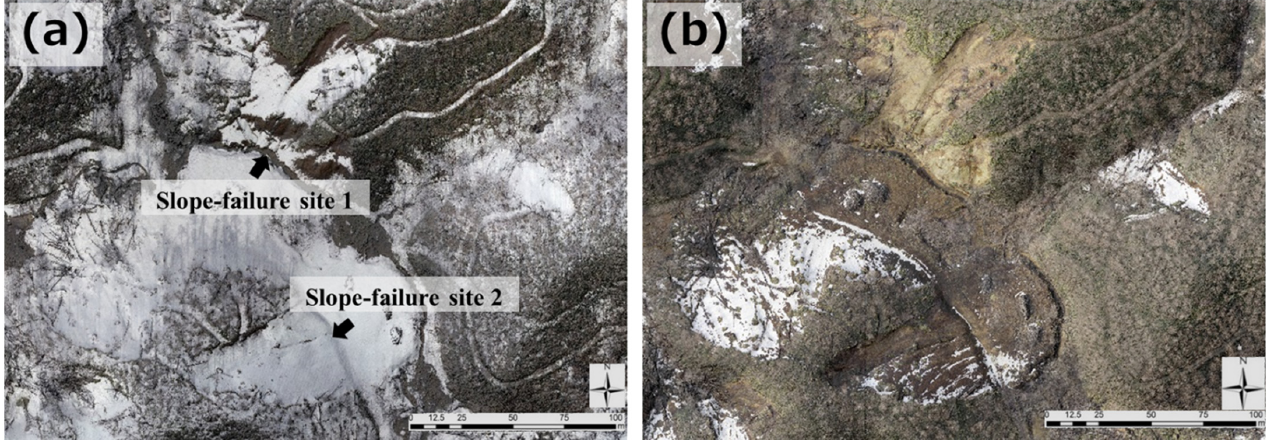
Figure 3. ( a ) Orthoimage of study area created from the P4R images on 3/13. ( b ) Orthoimages of study area created from the P4R images at 4/2 p.m. Table 2. Error and RMSE between the DSMs in the XYZ direction. 4/2 P.M.–4/3 A.M. 4/3 P.M.–4/3 No.